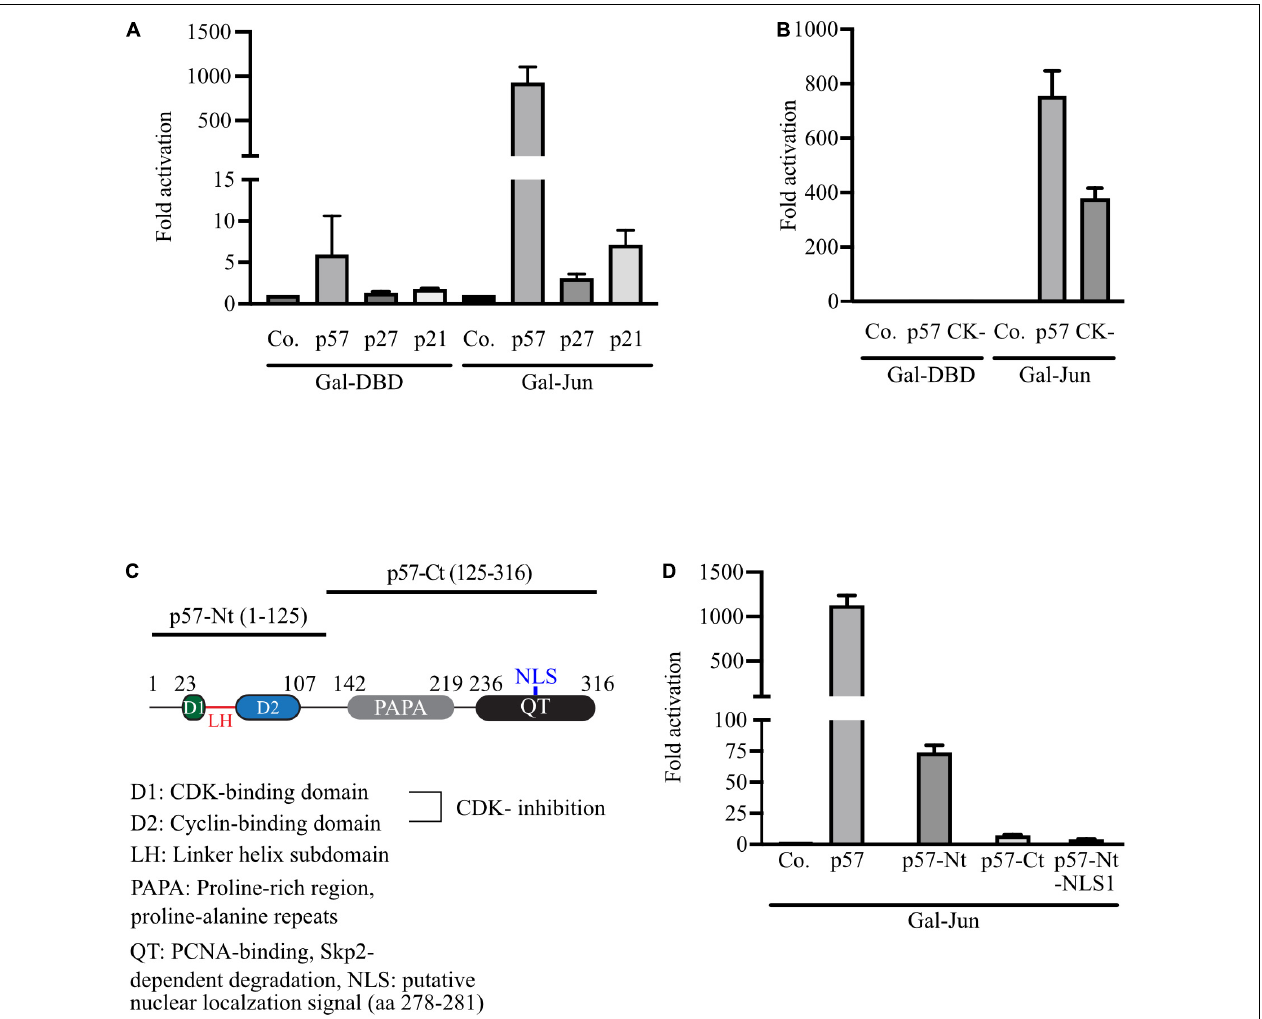
FIGURE 2 | Strong activation of Gal-Jun activity is specific for p57 and requires both, the N -terminal and C -terminal domains of p57. (A) Gal4-dependent luciferase reporter gene experiments comparing the effect of the Cip/Kip-family members p57, p27, and p21 on c-Jun transactivation. 293FR cells were cotransfected with DNA-expression plasmids for Gal-DBD, Gal-Jun and p57, p27 or p21. pUbi-Rluc (expressing renilla luciferase) served as a transfection control. A total of 30 h after transfection cells were harvested and subjected to Dual luciferase assays. Renilla-normalized values are expressed as fold activation relative to control transfected (Co.) which is set to 1. To represent minor activation, the y-axis is split into two segments (bottom: 0 to 15, top: 100 to 1,500). Shown is the mean ± SD from three independent experiments. (B) Similar experiment to (A) comparing p57 and cyclin/CDK-binding deficient p57 mutant. 293FR cells were cotransfected with DNA-expression plasmids for Gal-DBD, Gal-Jun and p57 or the cyclin/CDK-binding deficient p57-CK- mutant (CK-) and pUbi-Rluc. A total of 30 h after transfection, cells were harvested and subjected to dual luciferase assays. Renilla-normalized values are expressed as fold activation relative to control transfected (Co.) which is set to 1. Shown is the mean ± SD from four independent experiments. (C) Schematic representation of p57 and its N -terminal and C -terminal domains. Key structural or functional regions of human p57 are indicated. Numbers above indicate positions of amino acid flanking distinct regions. Amino acid including the N -terminal (p57-Nt) and C -terminal (p57-Ct) domains are shown in brackets. (D) Experiment as described above (A) analyzing the contribution of p57-domains to the activation of Gal-Jun by p57. 293FR cells were cotransfected with DNA-expression plasmids for Gal-Jun and p57 or the indicated p57 domain mutants. A total of 30 hours after transfection cells were harvested and subjected to Dual luciferase assays. Renilla-normalized values are expressed as fold activation relative to control transfected (Co.) which is set to 1. For showing lower fold activations, y-axis is split into two segments (bottom: 0 to 100, top: 100 to 1,500). Shown is the mean ± SD from three independent